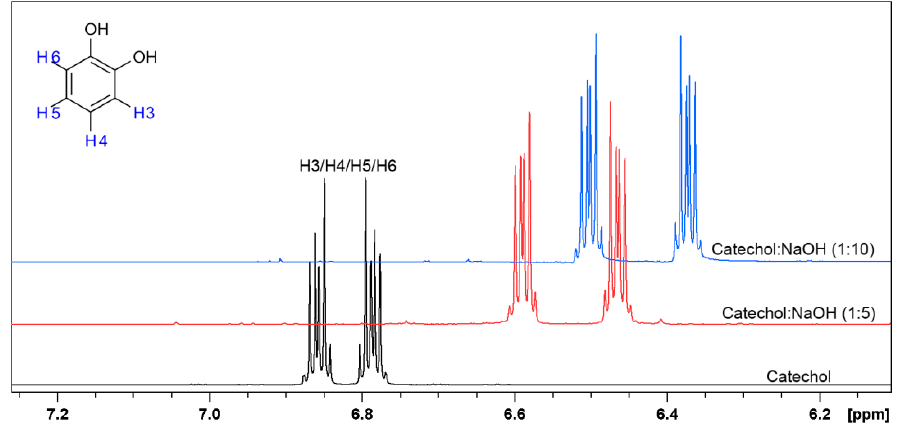
Figure 10. 1 H-NMR spectra of catechol in D 2 O (black line) and in the presence of NaOH in D 2 O in molar ratio 1:5 (red line) and 1:1 (blue line), respectively.